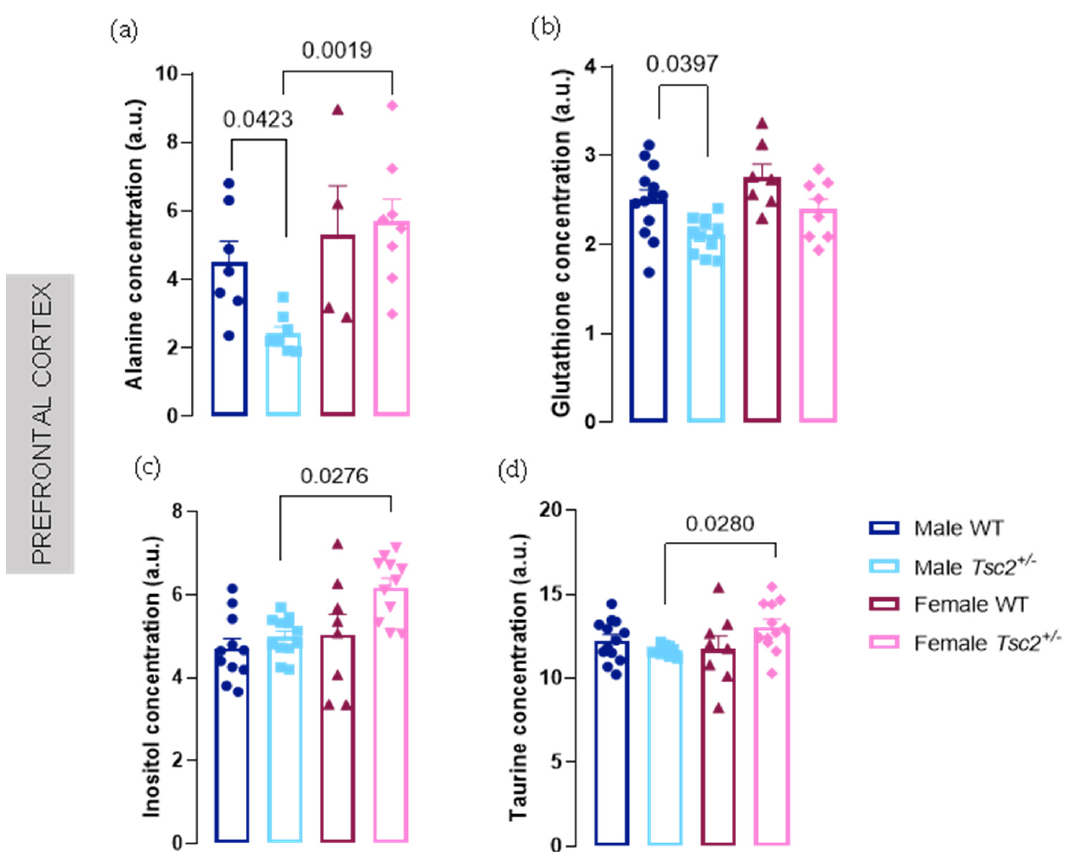
Figure 2. Tsc2 +/ − leads to sex-dependent cortical metabolite alterations. 1 H-magnetic resonance spectroscopy (MRS) analysis demonstrated a down-regulation of concentration levels of ( a ) alanine and ( b ) glutathione in male Tsc2 +/ − , compared with their littermates wild-type (WT). Additionally, it was observed a reduction in ( c ) inositol and ( d ) taurine in male transgenic mice but in comparison with transgenic females. The results are expressed as mean ± SEM. Alanine: 27 animals (7 male WT, 8 male Tsc2 +/ − , 4 female WT, 8 female Tsc2 +/ − ); glutathione: 39 animals (13 male WT, 11 male Tsc2 +/ − , 7 female WT, 8 female Tsc2 +/ − ); inositol: 42 animals (11 male WT, 12 male Tsc2 +/ − , 8 female WT, 11 female Tsc2 +/ − ); taurine: 43 animals (13 male WT, 10 male Tsc2 +/ − , 8 female WT, 12 female Tsc2 +/ − ).